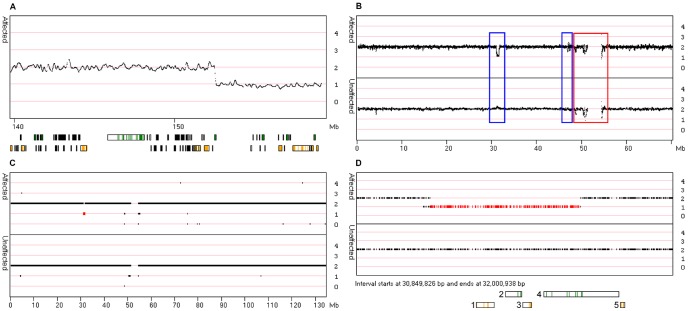
Detection of CNV using CNViewer.The ‘Smooth signal’ data for the tip of the long arm of chromosome 7 of Patient One has an extended run of values tending around 1, representing the presence of a 6.5 Mb deletion (Figure 1A). The position of genes in the interval is shown by the black rectangles below the main graph. The coloured blocks represent the location of the exons on the forward (green) and reverse (orange) strands. The ‘Smooth signal’ data, from a 70 Mb region of chromosome 11, for each individual in Pedigree One is overlaid on the upper (affected individuals) and lower graphs (unaffected siblings) in Figure 1B. The red box highlights regions where the CNVs are present in both affected and unaffected individuals, while the blue boxes identify CNVs that are present in the affected but not unaffected individuals. When the ‘CN state’ data for chromosome 11 is viewed with the ‘Show linked’ option selected, a single region starting at 31.7 Mb is highlighted (red bar, Figure 1C). When this region is expanded it can be seen that all the affected individuals contain a deletion, which is absent from the unaffected individuals (Figure 1D). This region contains 5 genes which are: 1 DCDC1; 2, DNAJC24; 3, IMMP1L; 4, ELP4; and 5, PAX6.